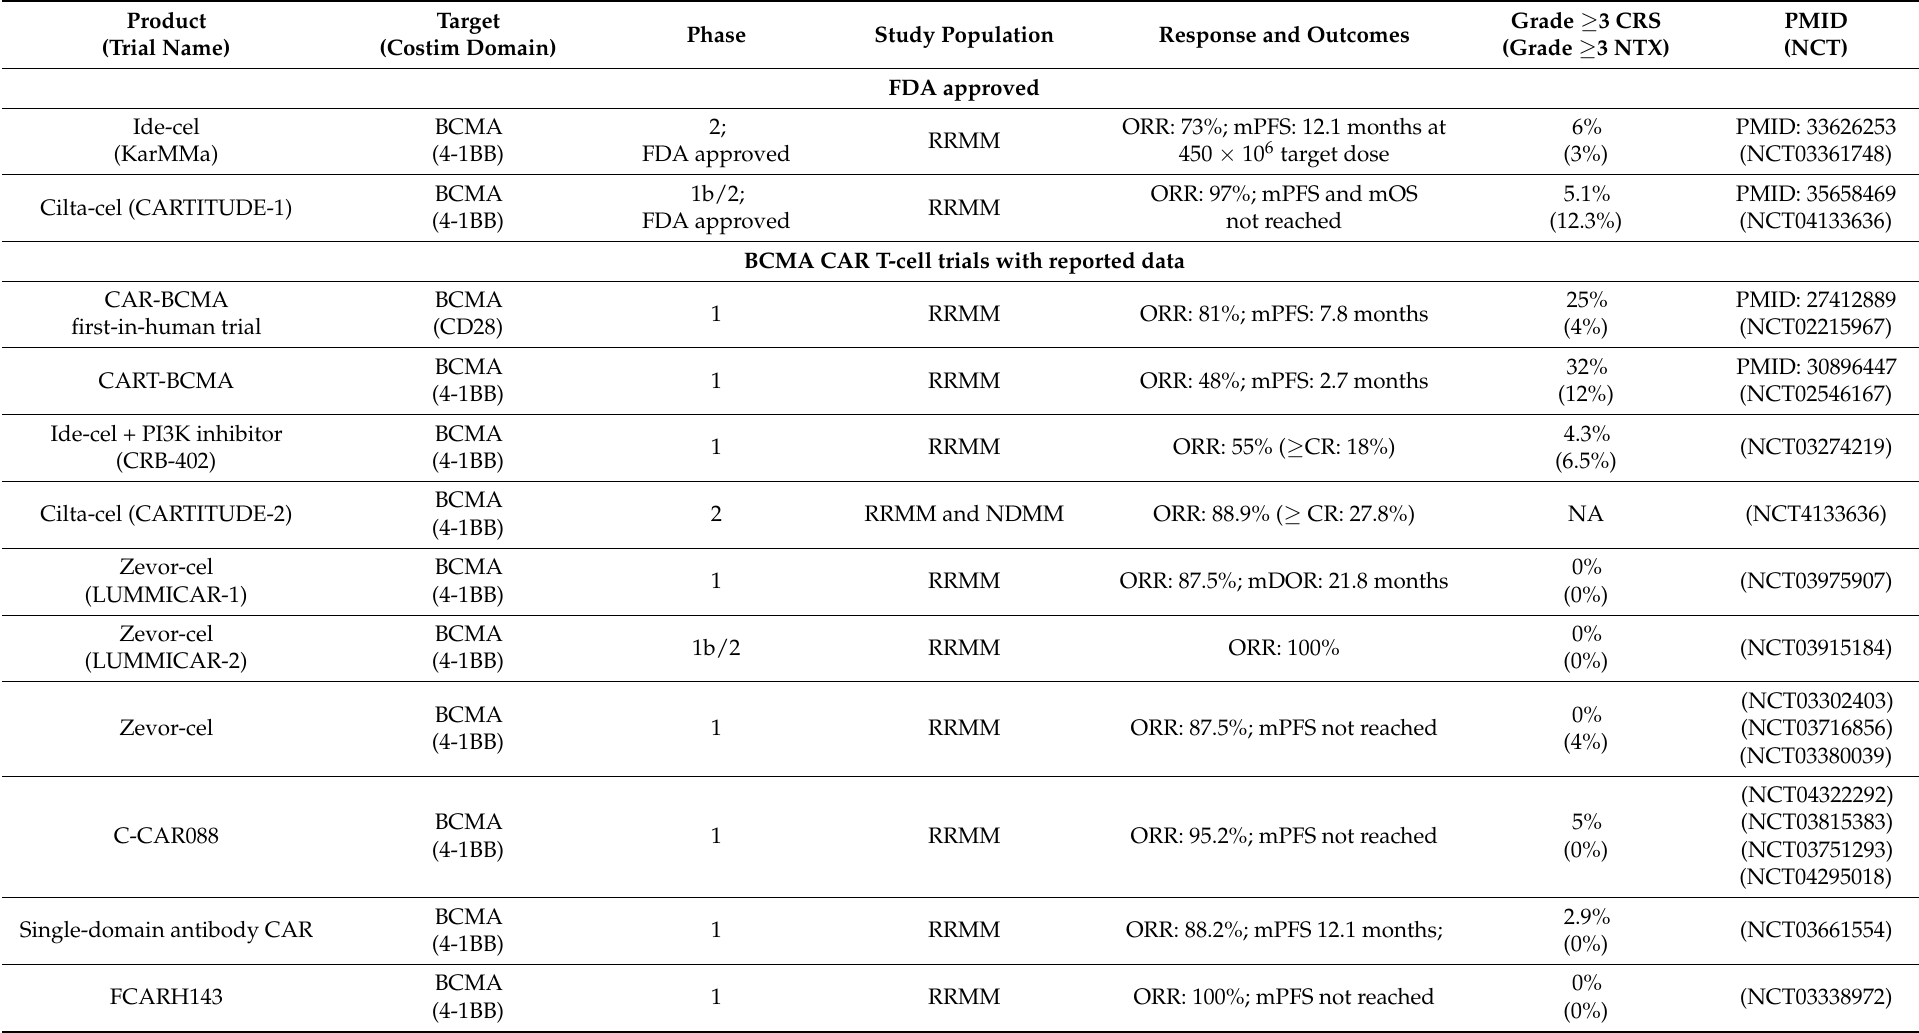
Table 1. Summary of CAR T-Cell Clinical Trials in